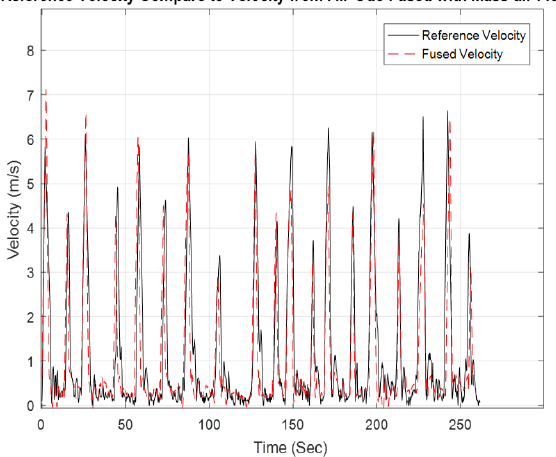
Figure 10. Velocity estimation from the proposed approach (Air-Odo and Mass-Flow sensor) compared to the reference velocity, showing the ability of the proposed system to sense lower and higher velocities compared to Air-Odo alone with additional weight added. 3.2.1 INS Dead-Reckoning Solution: Figure 11 shows the reference trajectory compared to the solution from the INS solution This experiment ensures the inability of the low-cost INS to estimate the navigation unknowns, during the absence of an absolute positioning system.